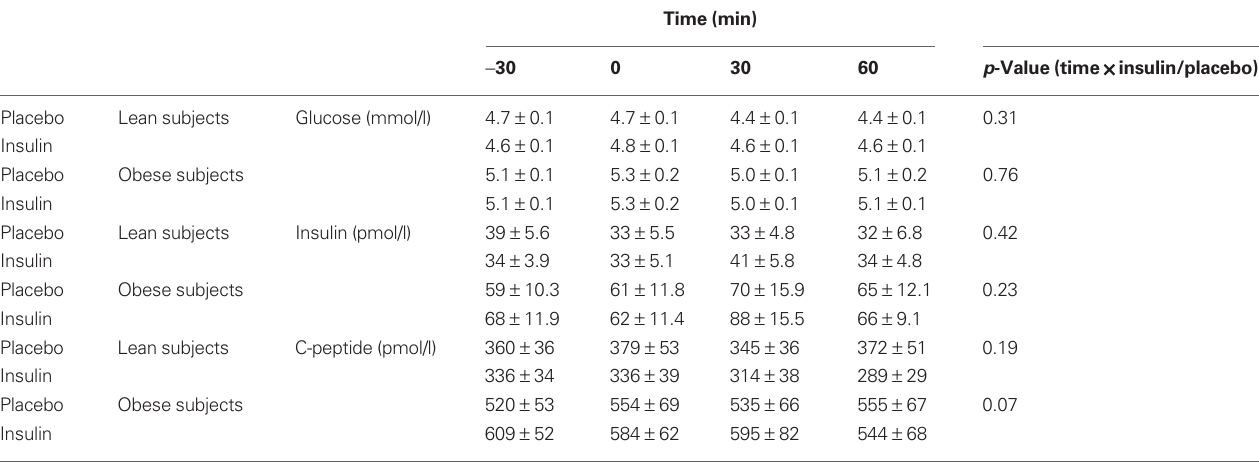
Table 2 | Metabolic parameters during MEG experiment (insulin or placebo spray was given at time = 0 min).